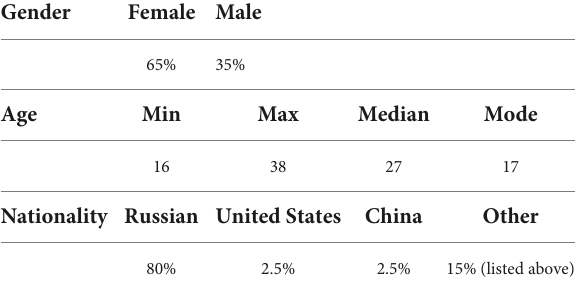
TABLE 1 Participants’ characteristics (author’s